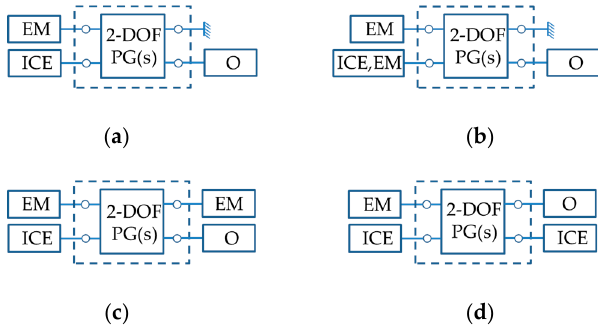
Figure 12. Four common connections of 2-DOF compound PG(s): ( a ) Type-I; ( b ) Type-II; ( c ) Type-III; ( d ) Type-IV.